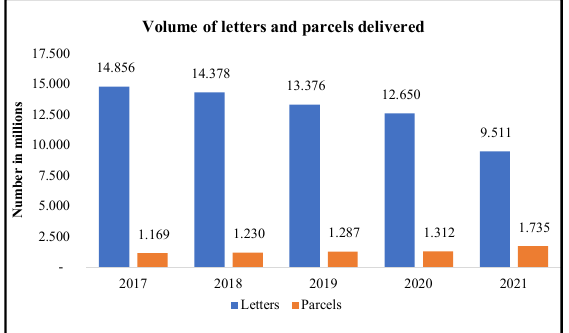
Figure 1. Volume of letters and parcels delivered through the UKPIL (UK parcels, international & letters) segment of the Royal Mail Group from 2017 to 2021